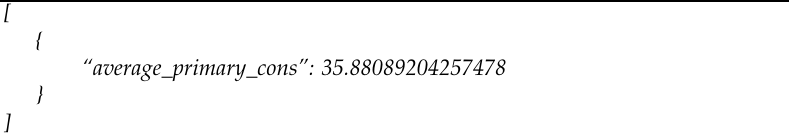
Table 4. Average consumption for buildings with a primary consumption.